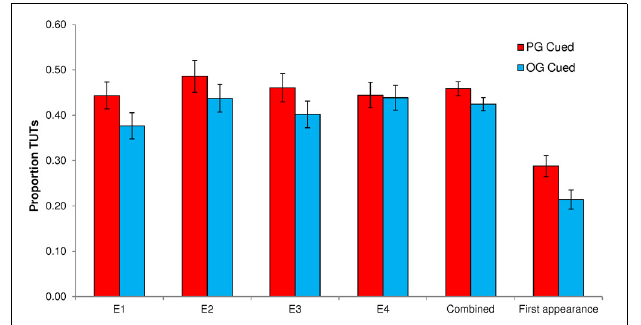
FIGURE 3 | Experiment 1 proportion of task-unrelated thoughts (TUTs) in the Sustained Attention to Response Task following personal-goal (PG) cues and other-goal (OG) cues, presented either 1, 3, or 5 non-target trials preceding the target and thought probe.